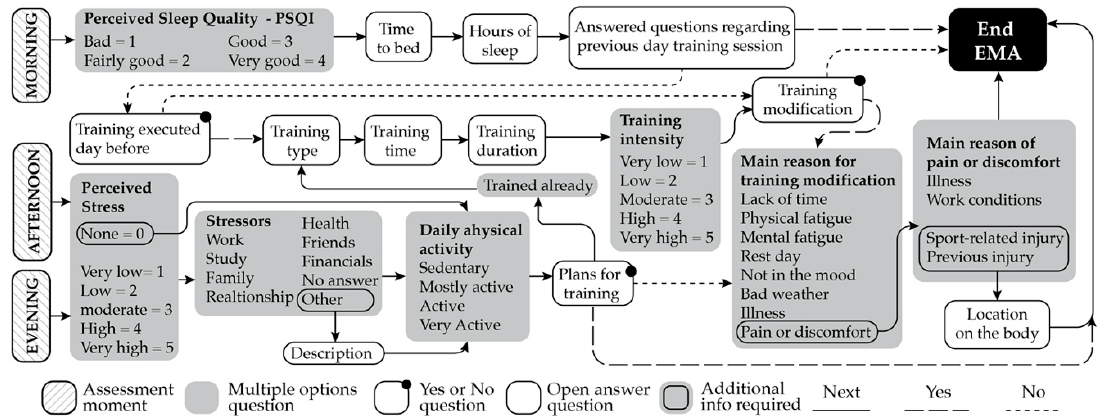
Figure 2. Structure of the mobile app Ecological Momentary Assessment (EMA) survey, and description of the data collected in the assessment